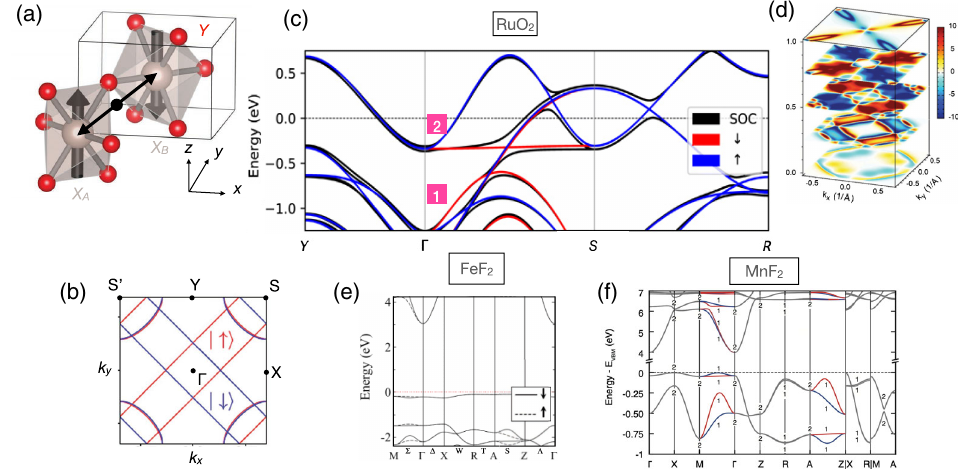
FIG. 3. (a) Schematics of the rutile XY 2 crystal structure with antiparallel magnetic moments on X (b) Brillouin zone of the rutile crystal and ab initio nonrelativistic calculation of a wave-vector k polarized Fermi surface of metallic RuO 2 . (c) Ab initio altermagnetic spin splitting of bands in RuO 2 , calculated without (red and blue) and with (black) relativistic spin-orbit coupling. (d) Ab initio altermagnetic spin-split Fermi surface for selected k correlations accounted for within the dynamical mean-field theory. (d,e) Ab initio altermagnetic spin-split bands of insulating FeF 2 and MnF 2 , respectively. This figure is adapted from Refs.